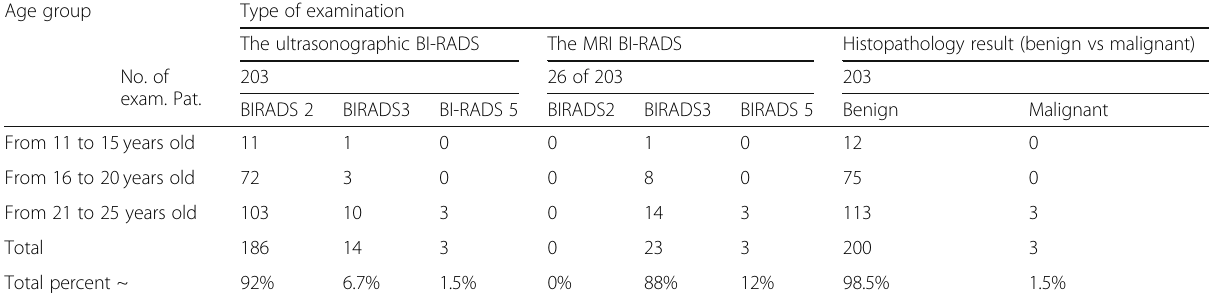
Table 6 Frequency analysis of examined patients regarding to age, BIRADS classification, and pathological results Age group Type of examination The ultrasonographic BI-RADS The MRI BI-RADS Histopathology result (benign vs malignant) No. of exam. Pat.